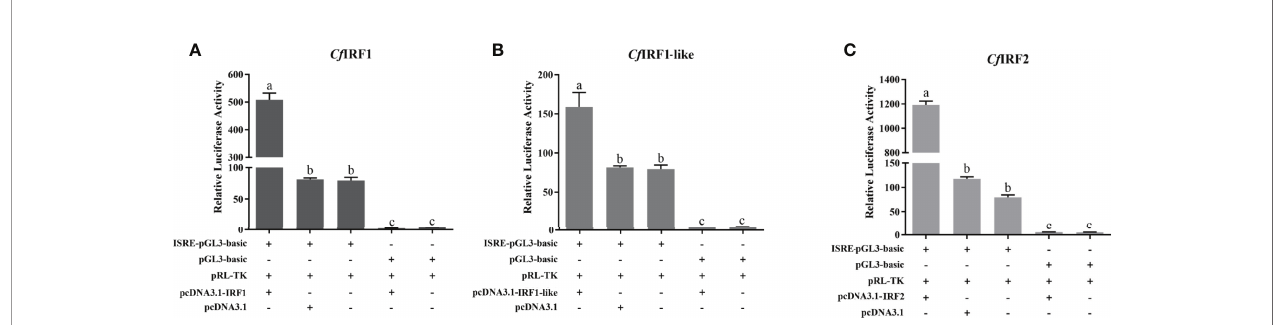
FIGURE 7 | Relative luciferase activity of expression Cf IRF plasmids on the luciferase reporter gene pISRE-Luc in HEK293T cells. (A) Relative luciferase activity of expression Cf IRF1 plasmids. (B) Relative luciferase activity of expression Cf IRF1-like plasmids. (C) Relative luciferase activity of expression Cf IRF2 plasmids. All of the groups were co-transfected with pRL-TK as internal reference. Vertical bars represent the mean ± S.E. ( N = 3). p -values are calculated by one-way analysis of variance (ANOVA) in SPSS software. Different letters indicate signi fi cant differences ( p